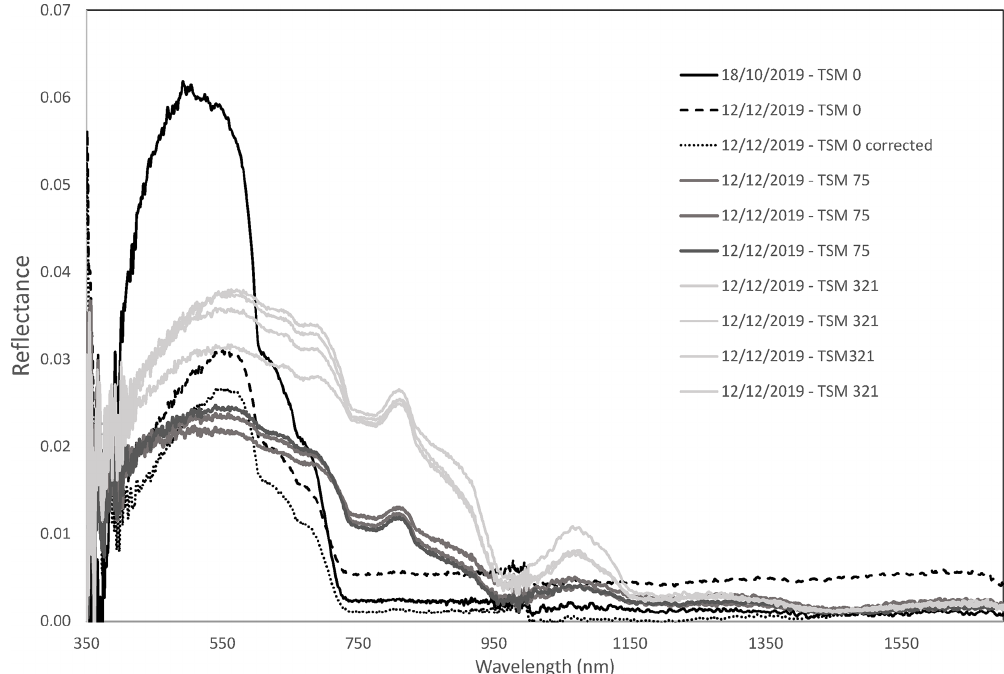
Figure 3. Spectral reflectance of tank water with various TSM.